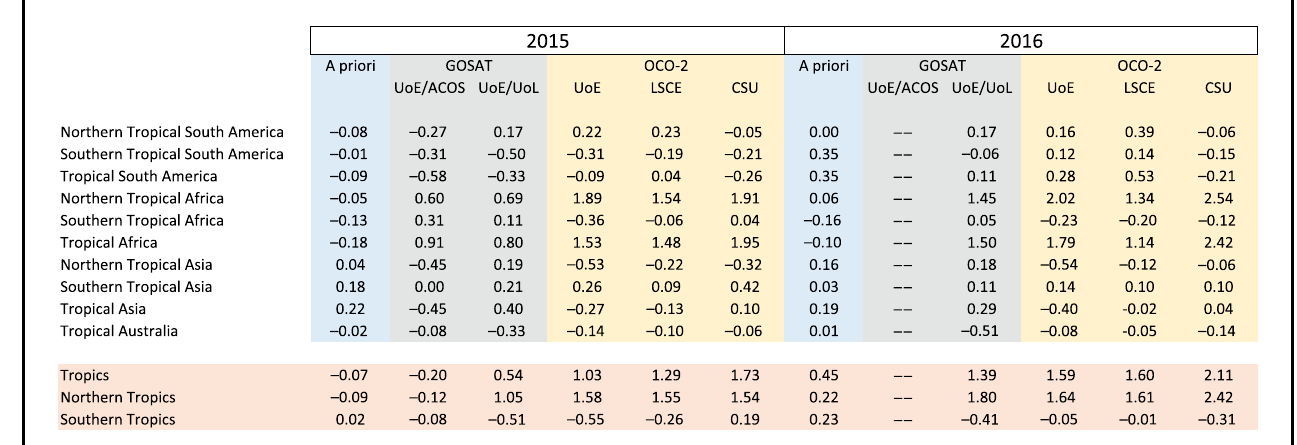
and 2015 for individual geographical regions over the tropics inferred from GOSAT and OCO-2 X CO2